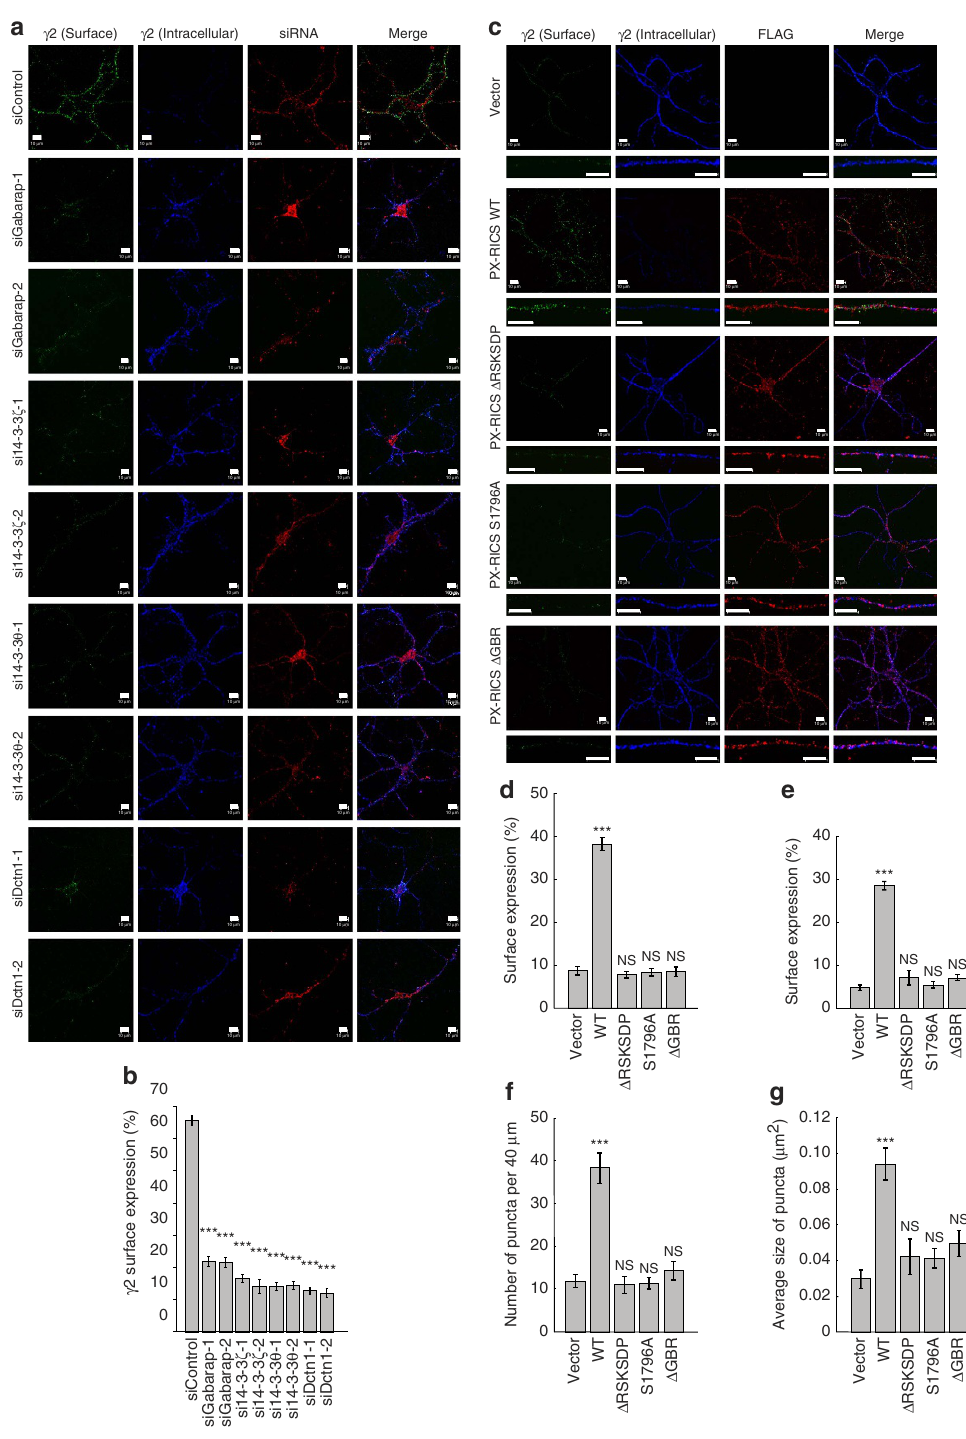
Figure 5 | The PX-RICS-dependent trafficking complex is required for surface expression of GABA A Rs. ( a ) Mouse cortical neurons (10 DIV) were transfected with the indicated siRNA (10nM) plus Red Fluorescent Oligo (10nM). Surface (green) and intracellular (blue) levels of the g 2 subunit in siRNA-introduced neurons (red) were analysed by surface labelling. The settings of the microscope, lasers and detectors were kept constant during image acquisition. Scale bars, 10 m m. ( b ) Quantitative analysis of surface-expressed and intracellular g 2. n ¼ 10 (images in each siRNA). ( c ) PX-RICS (cid:2) / (cid:2) cortical neurons (14 DIV) were transfected with plasmids expressing FLAG-tagged wild-type (WT) or mutant PX-RICS as indicated. D RSKSDP, a mutant lacking the 14-3-3-binding motif (amino acids 1,793–1,798); S1796A, a mutant in which Ser-1796, the CaMKII phosphorylation site in the 14-3-3 binding motif, is replaced with Ala; D GBR, a mutant lacking the GABARAP-binding region (amino acids 562–796). Surface (green) and intracellular (blue) levels of the g 2 subunit in transfected neurons (red) were analysed by surface labelling. The settings of the microscope, lasers and detectors were kept constant during image acquisition. Scale bars, 10 m m. ( d – g ) Quantitative analyses of surface-expressed g 2 in entire neurons ( d ) and the representative dendrites ( e ). The number ( f ) and averaged size ( g ) of surface-expressed g 2 puncta within 40- m m portion of the representative dendrites are also quantified using ImageJ. n ¼ 10 (images in each construct). Data are represented as means ± s.e.m. NS, not significant; *** P o 0.001 (unpaired two-tailed Student’s t -test, compared with siControl ( b ) or vector control ( d – g